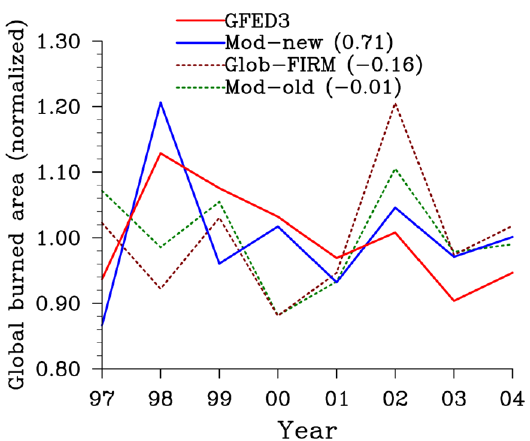
Fig. 12. Annual global burned area normalized by the mean for 1997–2004 from GFED3 and CLM-DGVM simulations with differ- ent fire parameterizations. The numbers in brackets denote temporal correlation between observations and